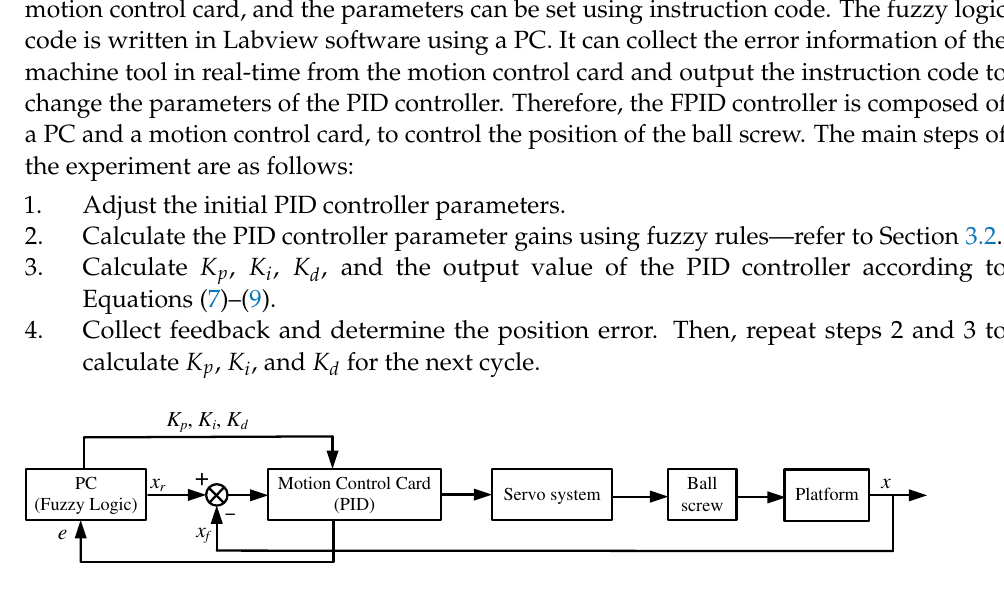
Figure 15. Experimental structure.